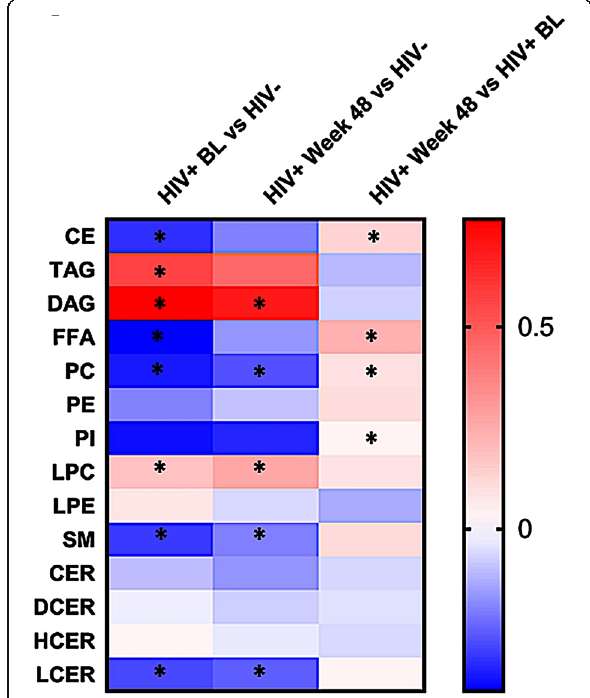
Fig. 1 The concentrations of lipid classes are altered by HIV infection and by ART. Lipid class concentrations ( μ M) were calculated from the sum of all molecular species within a selected class. Statistical significance between study groups with and without HIV was determined using 2-sample unpaired t tests, and among samples from PWH at baseline and after 48 weeks of ART, paired t testing was used. Heatmap data are represented as Fold Log2.